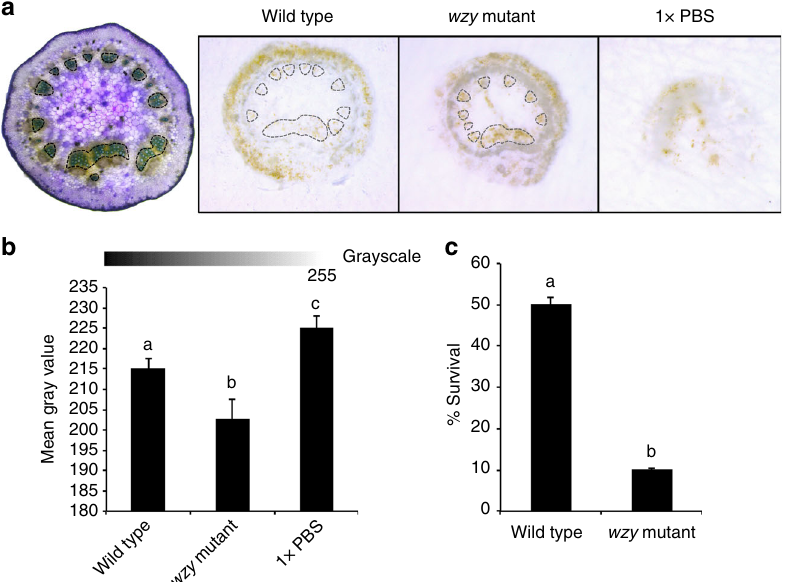
Fig. 2 In situ localization of O-antigen-modulated ROS production in the xylem in petioles of inoculated plants. a DAB-mediated tissue printing of petioles at 15 min post-inoculation indicated a strong production of H 2 O 2 speci fi cally in the xylem vessels of grapevines needle inoculated with wzy cells (location of xylem vessels emphasized with dotted outline). Vines inoculated with wild type Xf exhibited H 2 O 2 production predominantly in peripheral collenchyma tissue, with some production in the xylem vessels. Vines inoculated with 1× PBS buffer served as negative controls. b Mean gray value of grayscale- converted DAB-stained images, representing differences in staining intensity. Grayscale intensities vary from 0 to 255; 0 = black, 255 = white, with the values in between representing shades of gray. The mean gray value of DAB-stained images from wzy -inoculated plants is signi fi cantly lower than wild type or 1× PBS-inoculated plants, indicating a darker, or more intense stain, and thus higher amounts of H 2 O 2 . Treatments with different letters over the bars are statistically different ( P < 0.05, one-way ANOVA, Tukey ’ s adjustment, n = 9 per treatment). Error bars represent ± standard error of the mean. H 2 O 2 survival assay. c Suspensions of Xf wild type or wzy cells were incubated with a fi nal concentration of 100 μ M H 2 O 2 for 10 min, followed by dilution plating and enumeration. Survival percentages of wzy cells were signi fi cantly lower than Xf wild type cells ( P < 0.0001, Mann – Whitney U , n = 9 per treatment). Following treatment with H 2 O 2 , 10.1 and 50.2% of wzy and wild type cells survived, respectively. Data are means of three biological replications and error bars represent ± standard error of the chose a fi nal concentration of 100 μ M H 2 O 2 based on the lower (Fig. 3a). Signi fi cant correlation ( r = 0.71, P = 1.37 × 10 − 06, Pearson correlation, 9 genes, n = 3 per treatment) between threshold of ROS detected by the DAB staining method (DAB RNAseq and qRT-PCR data was detected when we examined the staining detects H 2 O 2 in the range of 100 μ M – 10 mM) 29 . To mirror the kinetics of peak ROS production seen in vivo, we expression of a subset of genes from all groups that exposed the cells to H 2 O 2 for 10 min. Both wild type and wzy cells showed upregulation in response to wild type and wzy cells were affected by treatment with H 2 O 2 , but signi fi cantly fewer wzy (Supplementary Data 2). Functional pathways induced as a result cells survived (10.1%), compared to wild type cells (50.2%) of inoculations with wild type or wzy mutant cells were (Fig. 2c). determined by enrichment analysis ( P < 0.05, hypergeometric test, n = 3 per treatment) of functional categories in the groups of upregulated genes (Fig. 3b, c; Supplementary Data 3). Group I corresponded to 200 genes signi fi cantly upregulated only in response to the wzy mutant at 8 h post-inoculation, but not to inoculation with wild type cells. Notably, genes associated with plant responses to biotic stresses were predominantly enriched in this group. This included the enhanced expression of several pathogenesis-related (PR) genes, including two PR-1 precursors ( VIT_03s0088g00700, VIT_03s0088g00710 ), β -1,3 glu-